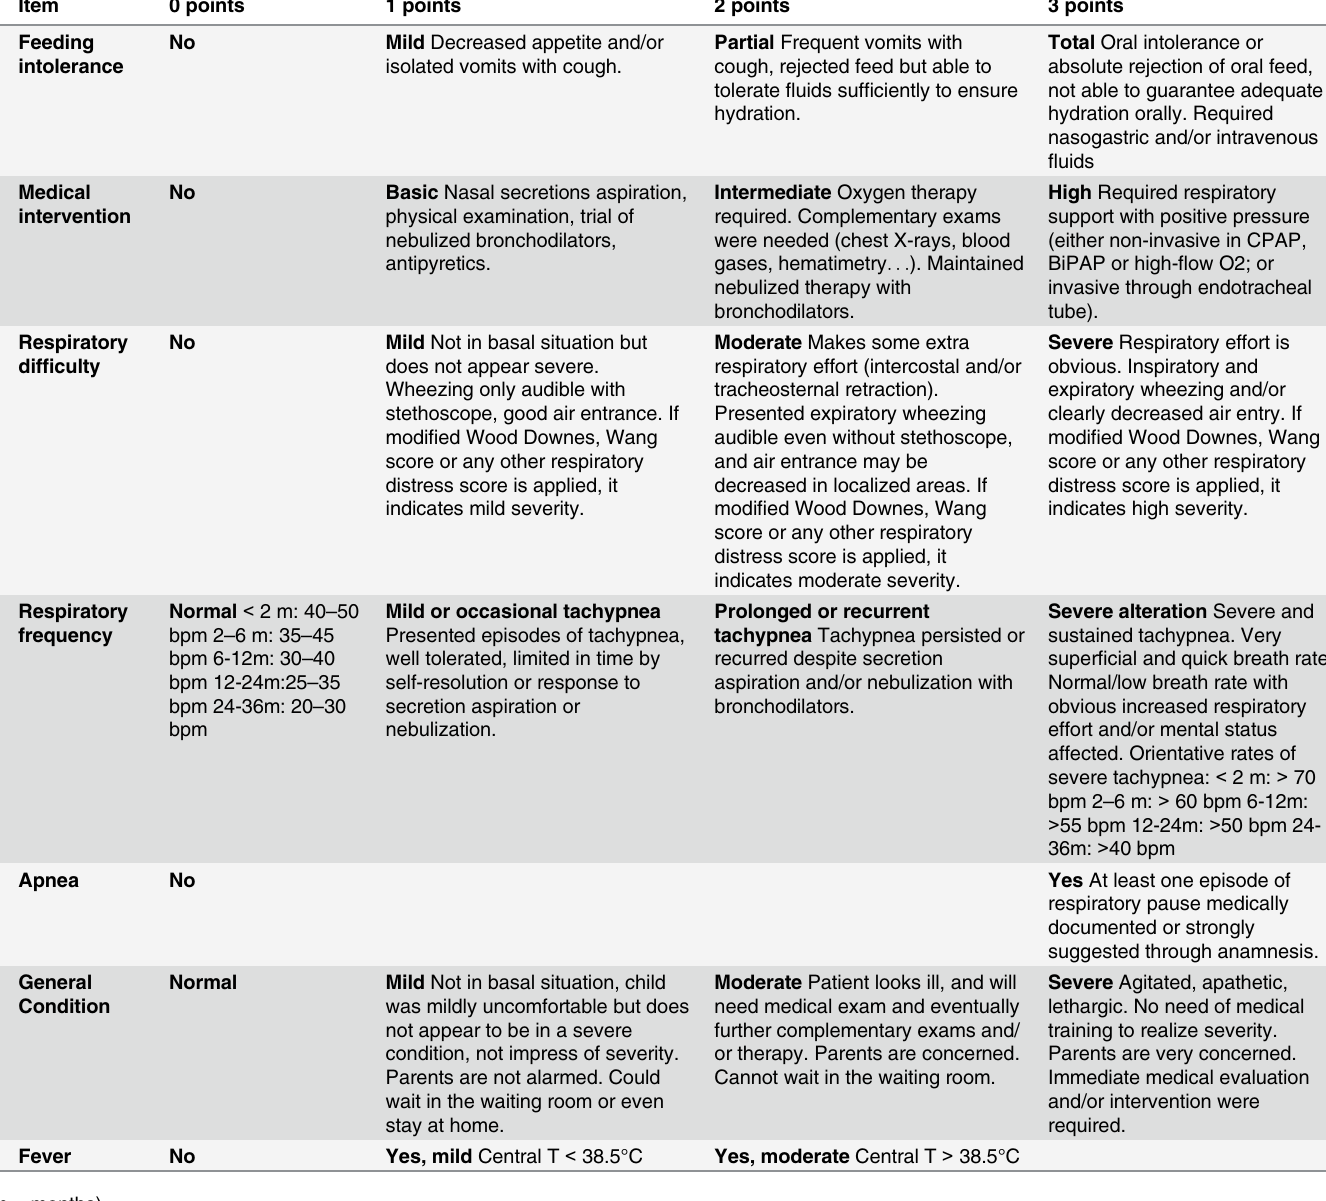
Table 1. ReSVinet scale. This table presents the original scale, and was the one used by the three